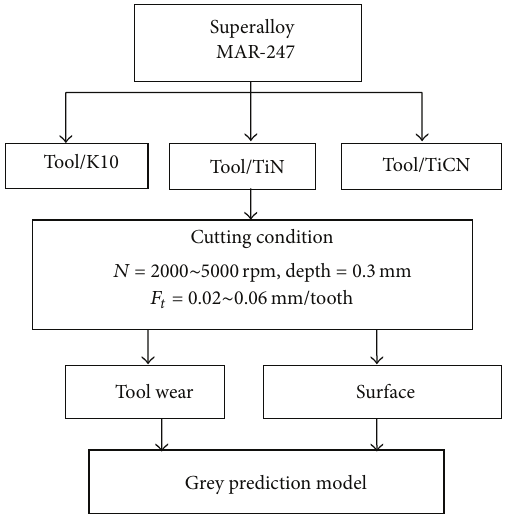
Figure 3: Experimental procedure chart.